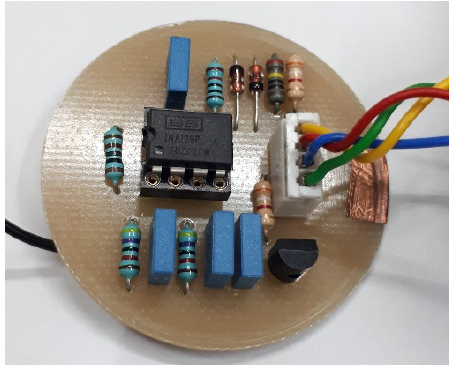
Figure 5. Electronic acoustic transducer circuit.